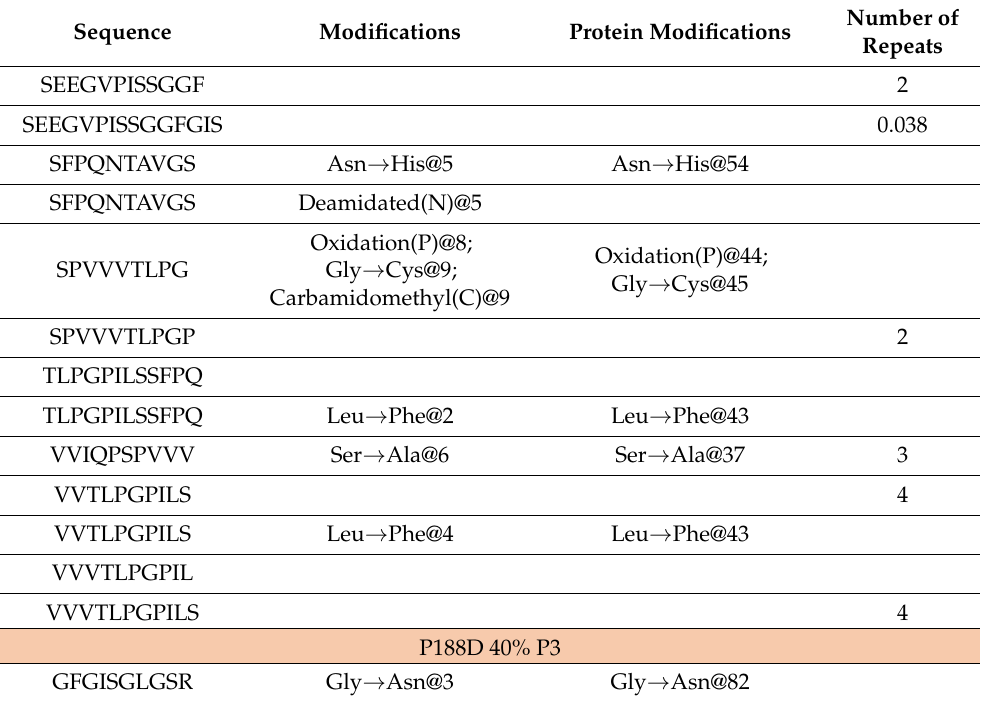
Table 6. Cont. Sequence Modifications Protein Modifications